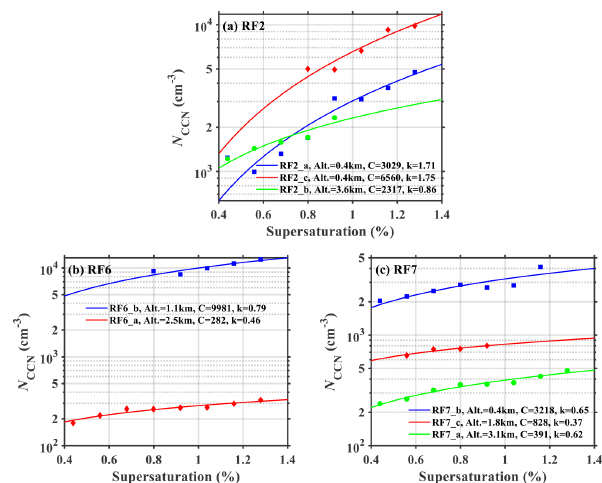
Figure 5. Fitted CCN spectra at different altitudes during three flights: (a) RF2, (b) RF6, and (c) RF7. The flight code, flight alti- tude (Alt.), and the two fitting coefficients from Twomey’s relation ( C and k ) are given in each panel. Solid lines are the fitting lines described by Eq. (1). The y axis is